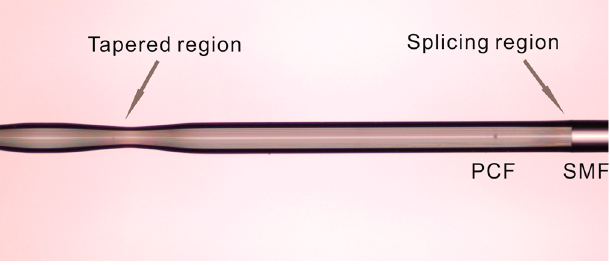
Figure 15. Microscope image of singlemode-periodically tapered PCF-singlemode fiber sample.